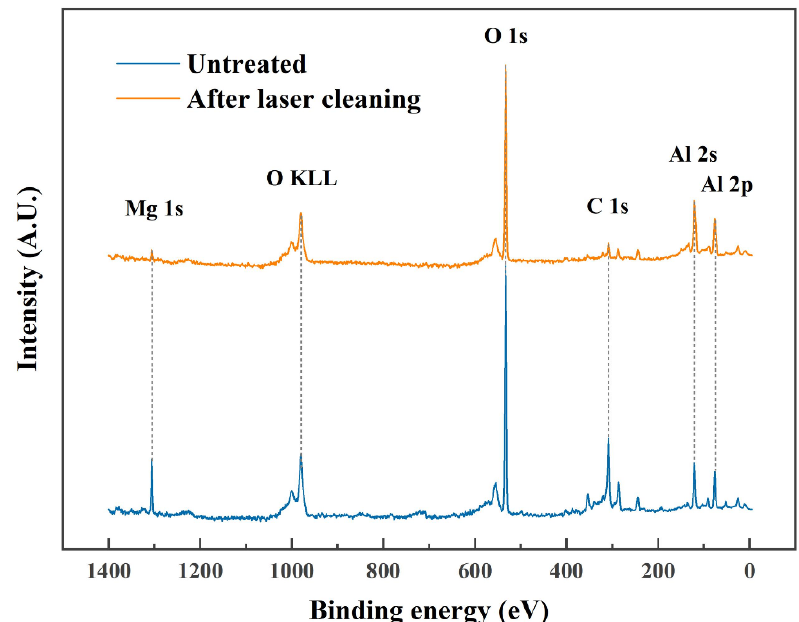
Figure 4. The XPS spectrum of the surface of 6005A alloy with untreated and laser cleaned .